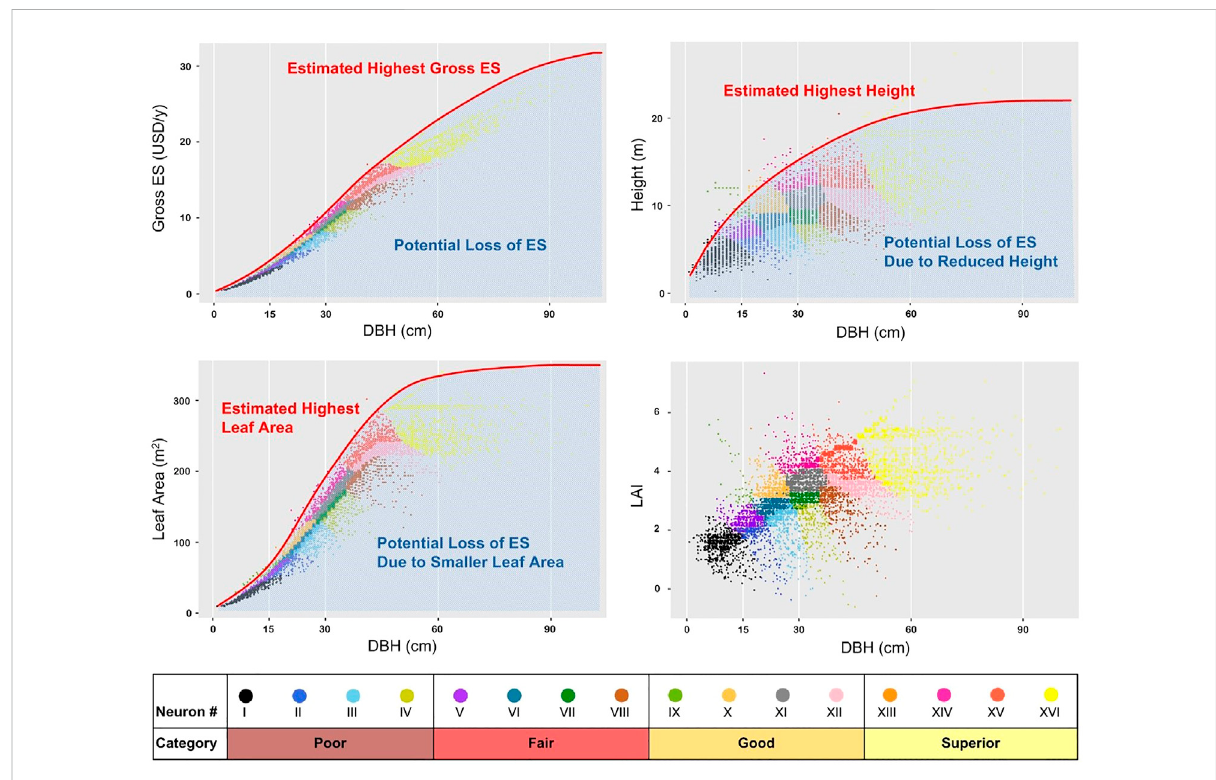
FIGURE 5 BasedontheSOM,wedisplaytheindividualspecies ’ (e.g., Cinnamomumcamphora here)associationsofDBHtogrossES,leafarea,height,and LAI by scatter plots to detect potential issues for improving urban forestry management and enhancing